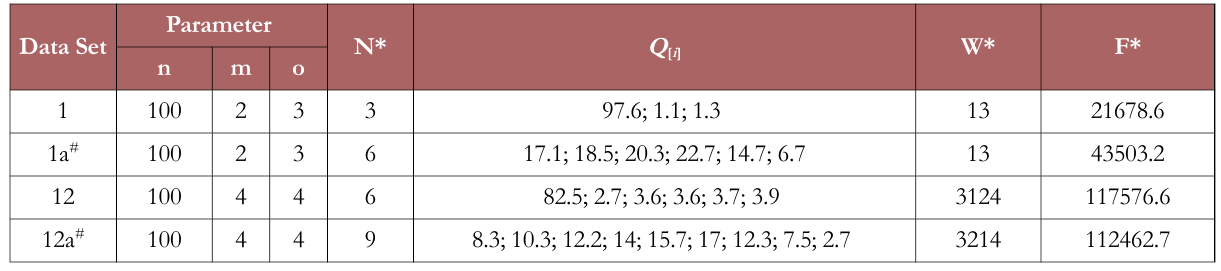
Table 4. Impact of learning and forgetting elimination to Data Set 1 and